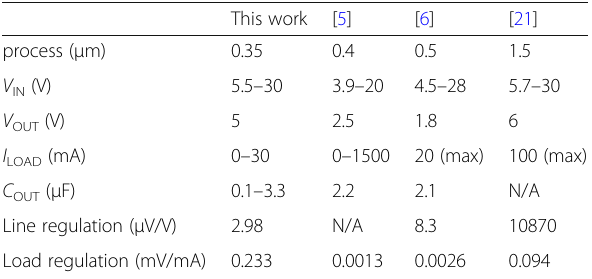
Table 2 Performance comparison of the proposed LDO with LDOs of wide power supply